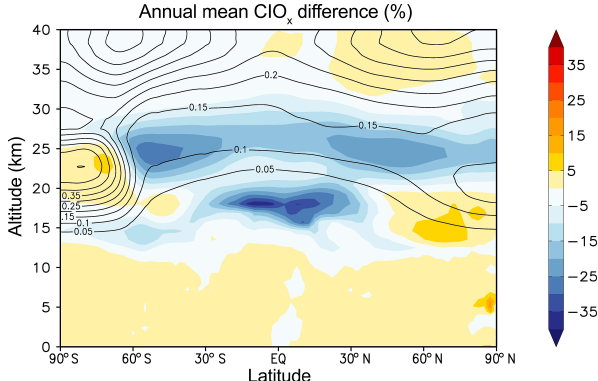
Figure 6. Simulated annual-mean, zonal-mean N 2 O 5 percentage differences between TiO 2 injection (S3) and the Mt Pinatubo erup- tion (S2). Black contour lines show N 2 O 5 mixing ratios from the Mt Pinatubo simulation (S2) in ppbv.